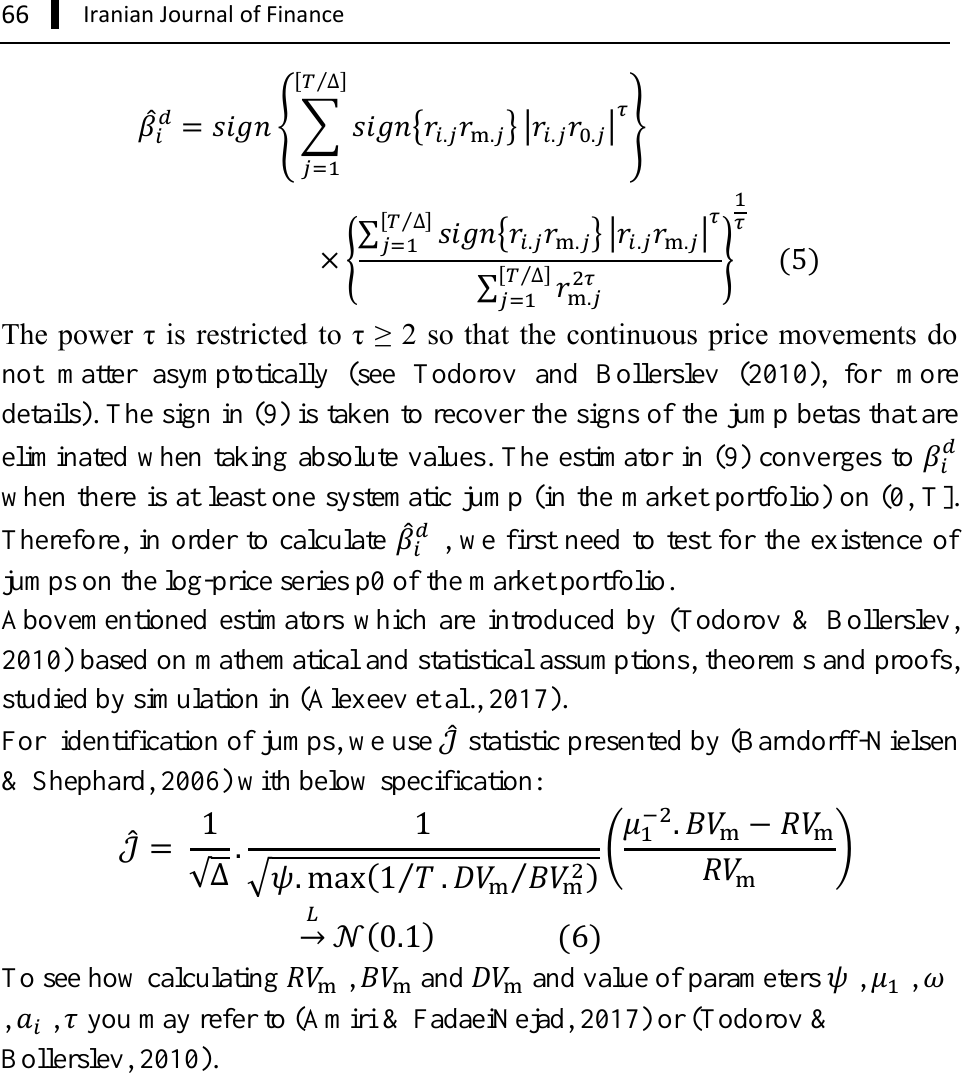
Table 1: sample firms classified by